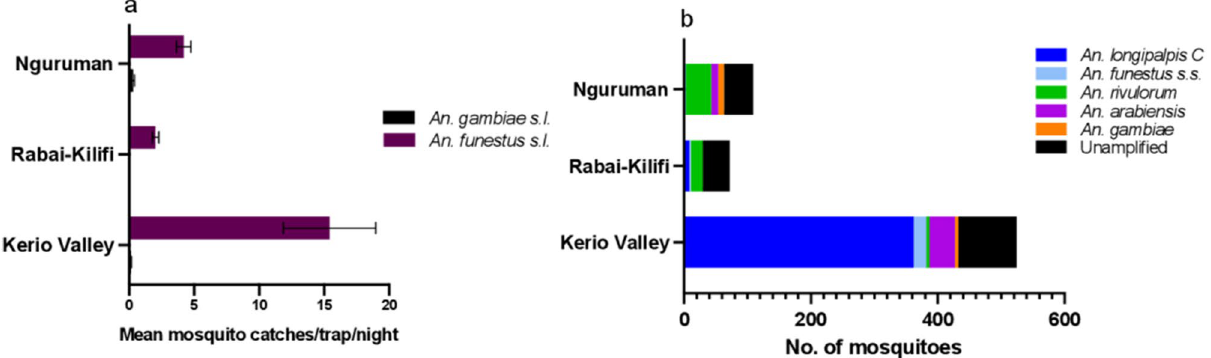
Figure 2. ( a ) Outdoor mean catches/trap/day, ( b ) Species composition, in three study areas in dryland areas of Kenya. The number of trap nights were 44, 50 and 56 in Kerio Valley, Rabai and Nguruman, respectively.